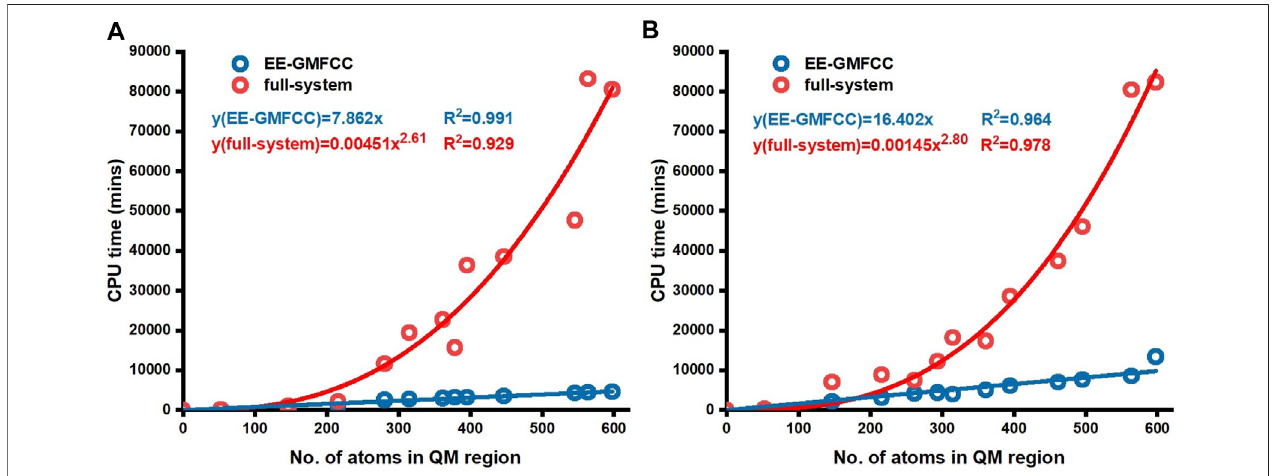
FIGURE 6 | CPU time for conventional full-system and EE-GMFCC calculations as a function of the number of atoms of the truncated model systems. The calculations were performed (A) at the TD-HF/6-31G* level and (B) at the TD- ω B97X/6-31G* level, respectively.